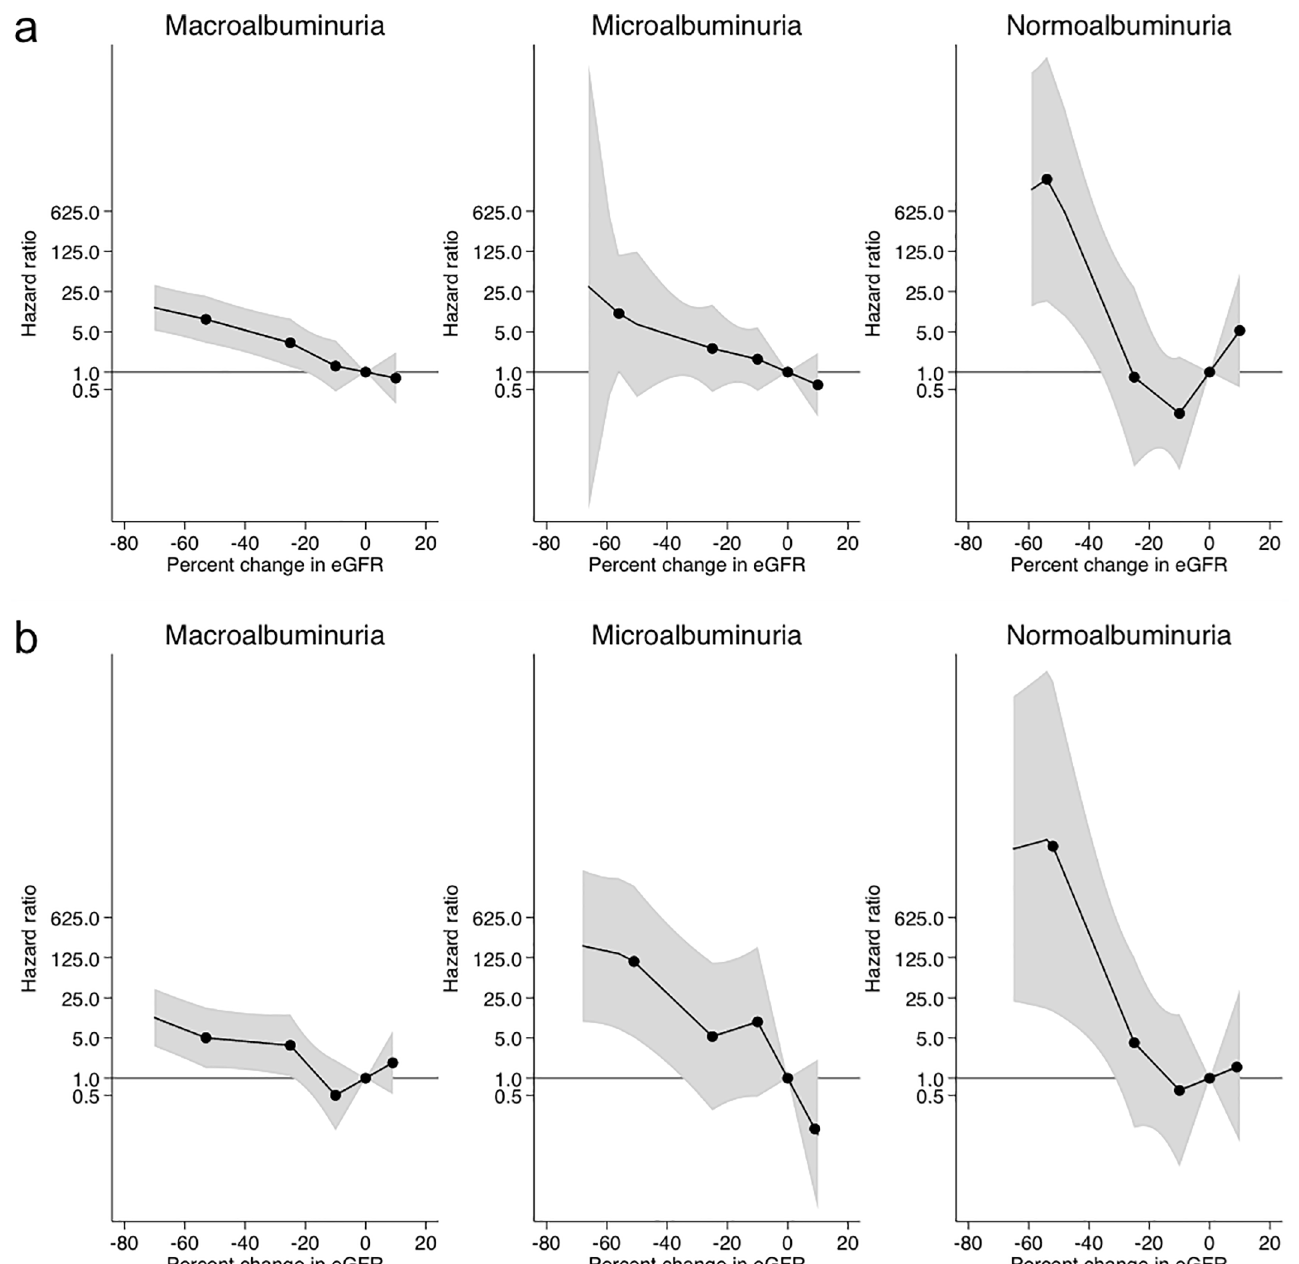
Fig 3. Adjusted hazard ratios of end-stage renal disease according to percent changes in eGFR during the (a) 2-year or (b) 3-year baseline period in subgroup analysis based on baseline urinary albumin levels. The model was adjusted with gender, age, systolic blood pressure, baseline eGFR, baseline urinary albumin, and history of cardiovascular disease. Knots were placed at −53%, −25%, −10%, and 10%. A reference point was set at 0% change in eGFR. Value trimmed at less than −70% and > 10% change in eGFR.